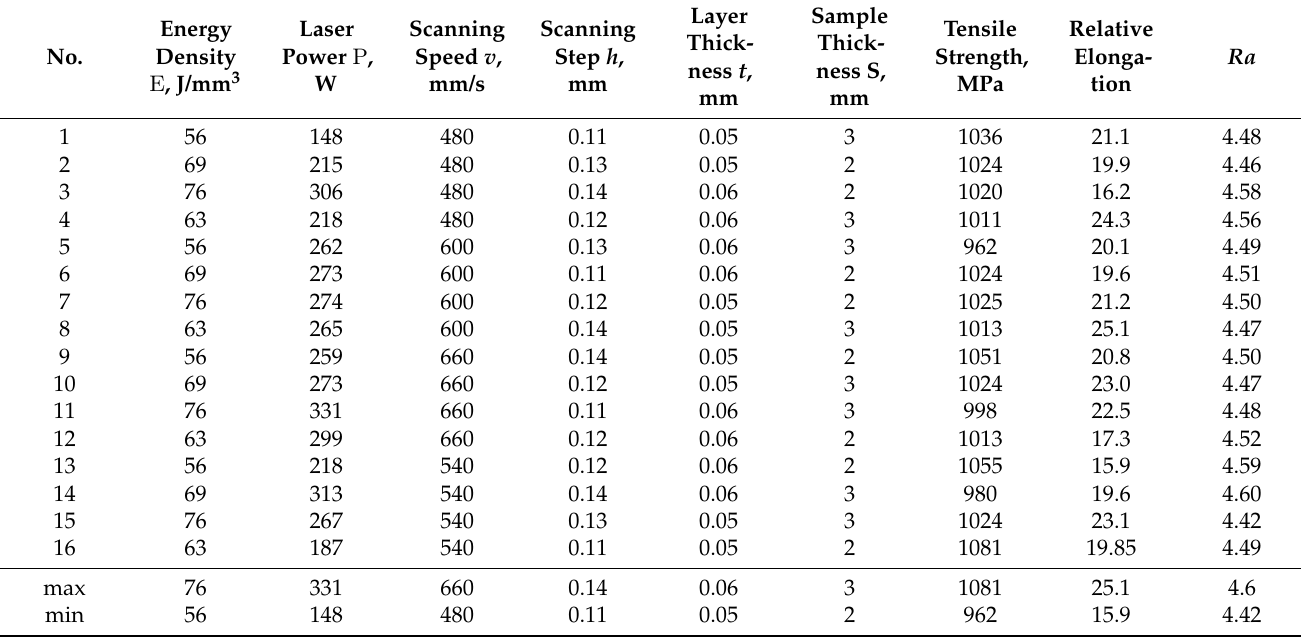
Table 2. Technological modes and test results for mechanical properties.